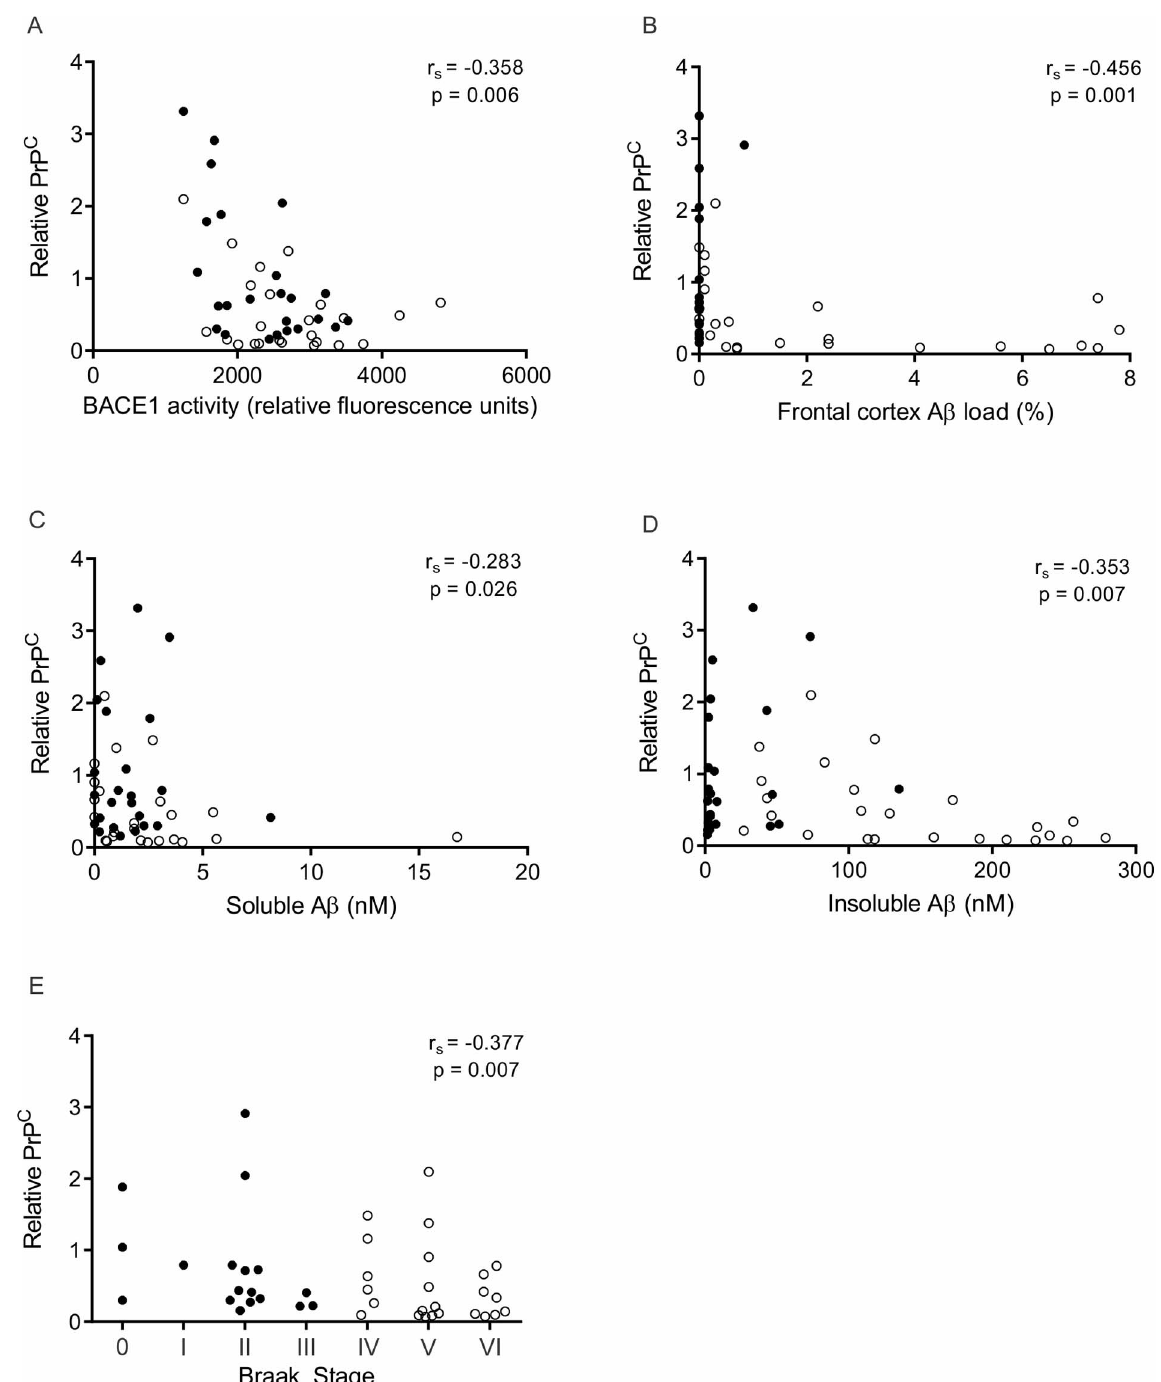
Figure 2. PrP C inversely correlates with BACE1 activity, A b load, soluble and insoluble A b and Braak stage. Relative PrP C protein levels were plotted against BACE1 activity (A), A b load (B), soluble A b (C), insoluble A b (D) and Braak stage (E) for each subject in the cohort (n=48. Control, filled circles; AD, empty circles). PrP C significantly inversely correlates with BACE1 activity, A b load, soluble A b , insoluble A b and Braak stage as determined by Spearman’s rank correlation coefficient (r s ).